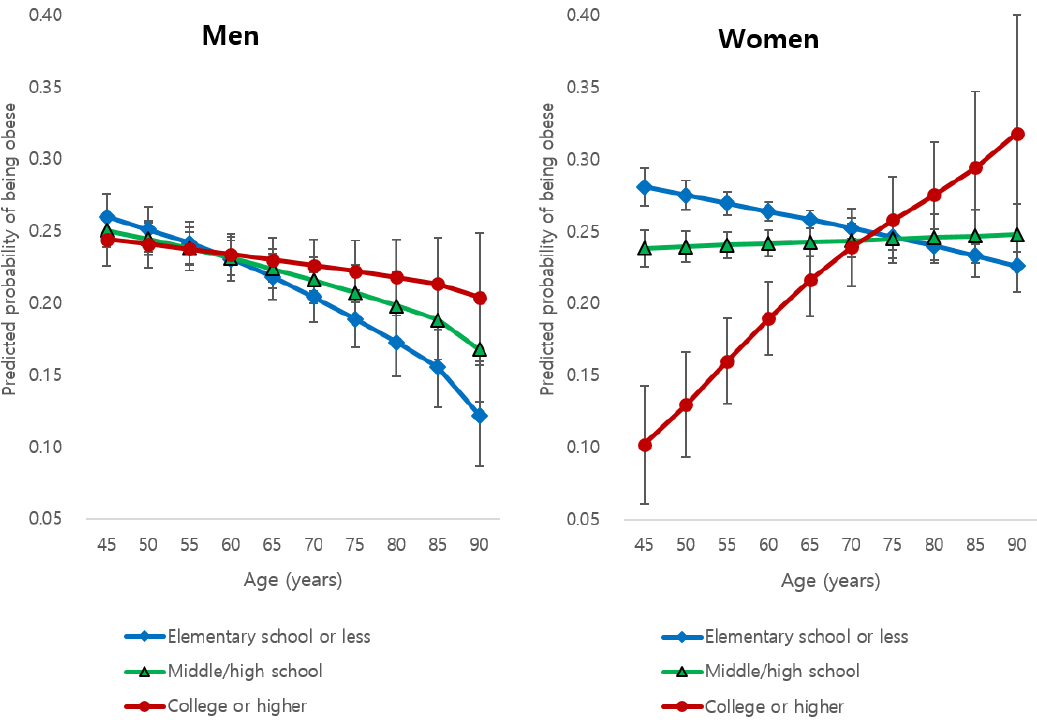
Figure 1. Gender-specific changes in the predicted probability of obesity during ageing for each education level and its 95% confidence interval.